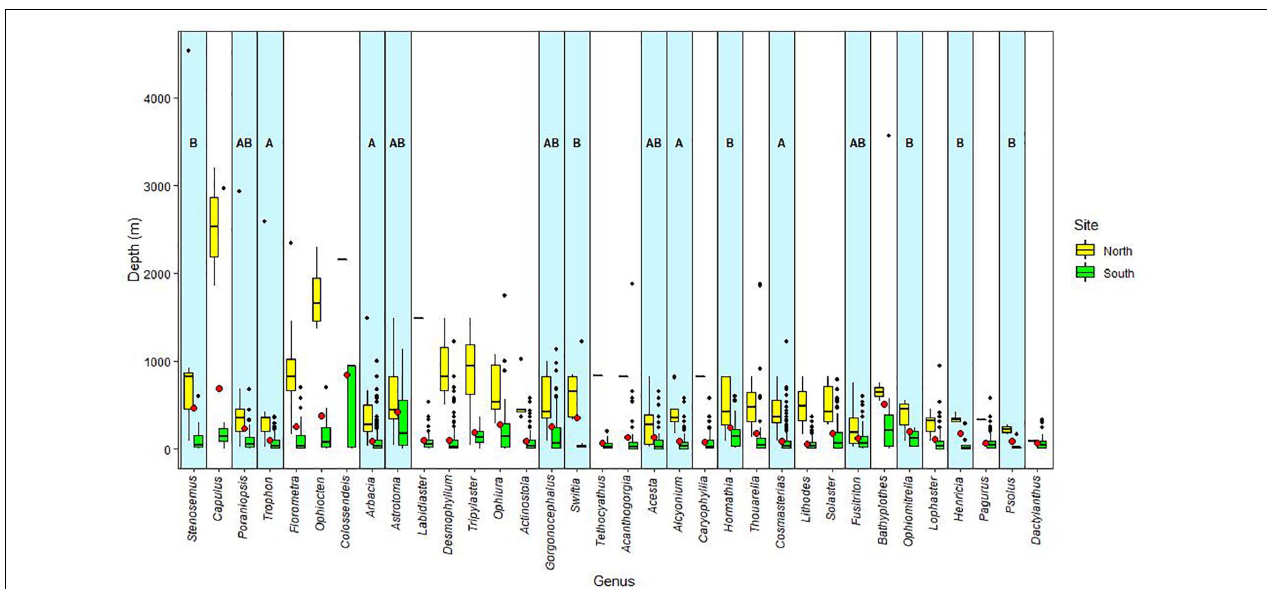
FIGURE 3 | Average depth of analyzed species and genera north (“North” corresponding to 18–40 ◦ S) and south of 40 ◦ S (“South,” corresponding to 40–56 ◦ S). A: genera with significant positive coefficient for depth in “North”; B: genera with significant negative coefficient for depth in “South”; AB: genera with pattern A and B. (see Häussermann and Försterra, 2009). The OMZ has a powerful along the Chilean coast (Thiel et al., 2007). In the southern fjords